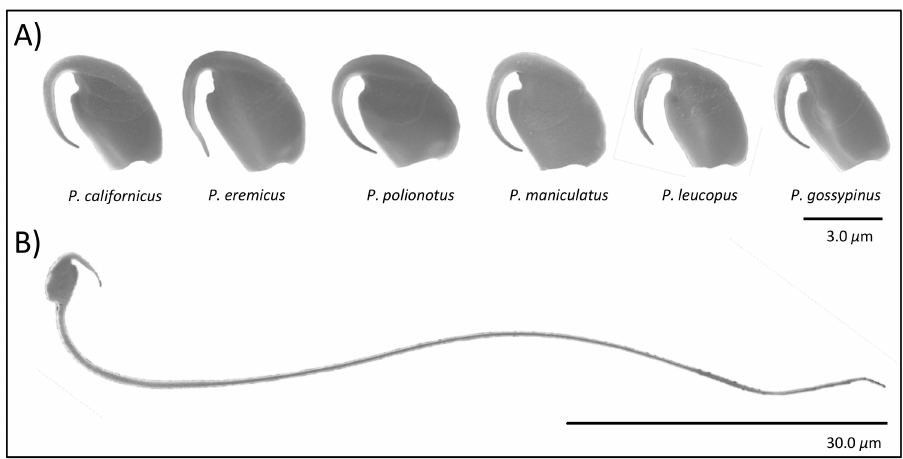
Figure 1. Representative images of sperm heads of six closely related species of Peromyscus mice ( A ) and a full Peromyscus maniculatus sperm cell ( B